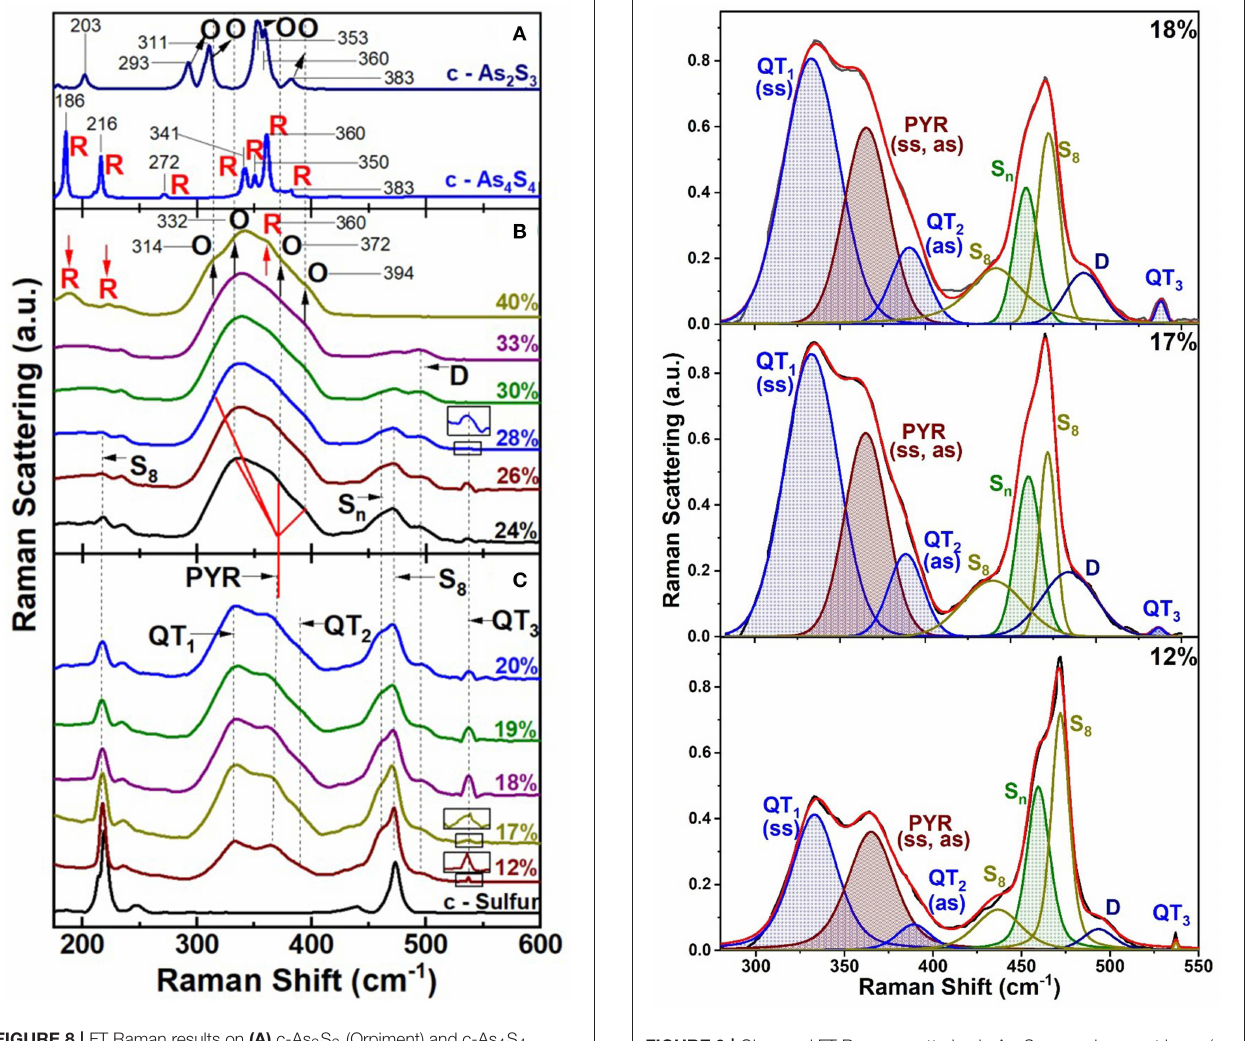
FIGURE 9 | Observed FT Raman scattering in As x S 100 − x glasses at low x ( < 18%) deconvoluted in terms of a superposition of requisite number of Voight profiles as illustrated in the plots. See text and Table 1 for the mode